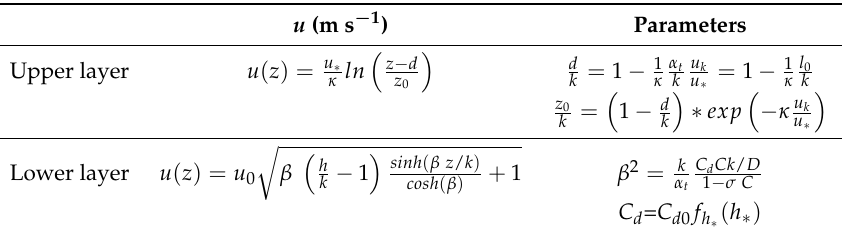
Table 3. Models used to compute vertical velocity profile in the case of submerged roughness [14]: d is the displacement in the logarithmic law, z 0 is the hydraulic roughness, α t is a turbulence length scale between the macro-roughnesses, and κ the von Kármán constant (=0.41). The expression of these parameters results from the continuity of velocity and its gradient at the top of the roughness